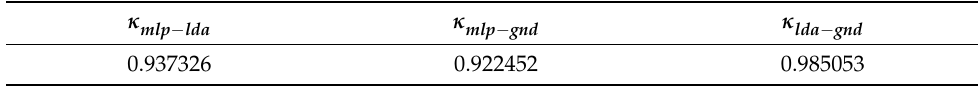
Table 3. Cohen’s kappa coefficients ( κ ) comparing